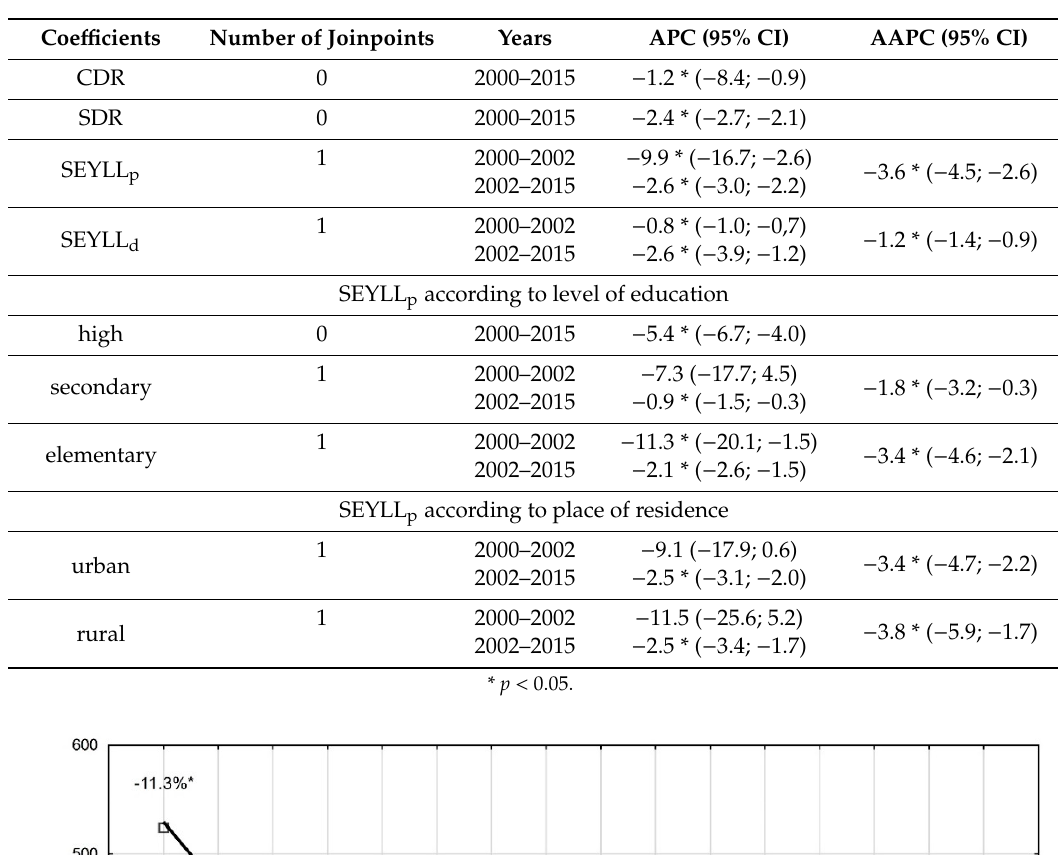
Table 2. Time trends of CDR, SDR, SEYLL p , and SEYLL d due to cervical cancer in Poland in 2000 to 2015—joinpoint regression analysis.